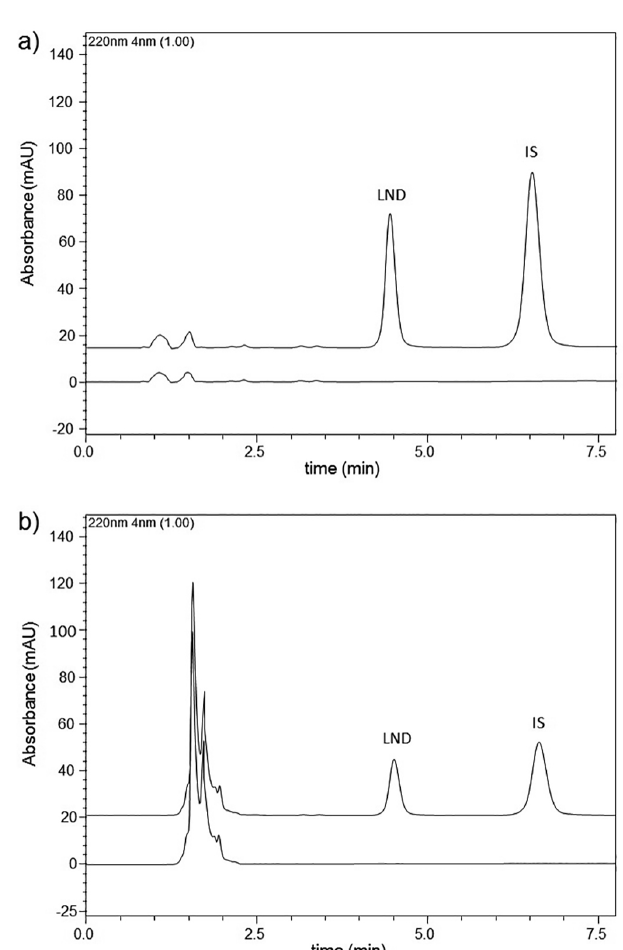
FIGURE 2 - Representative chromatograms corresponding to (a) lenalidomide loaded PLGA-NPs with IS (thalidomide) and blank PLGA-NPs and (b) lenalidomide spiked in rat plasma with IS (thalidomide) and processed blank rat